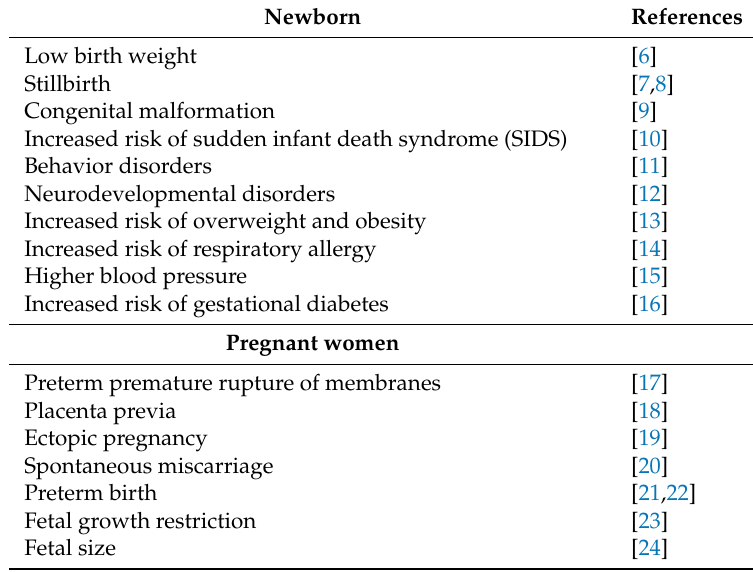
Table 1. Literature review on the adverse effect of smoking on the progress of pregnancy and the